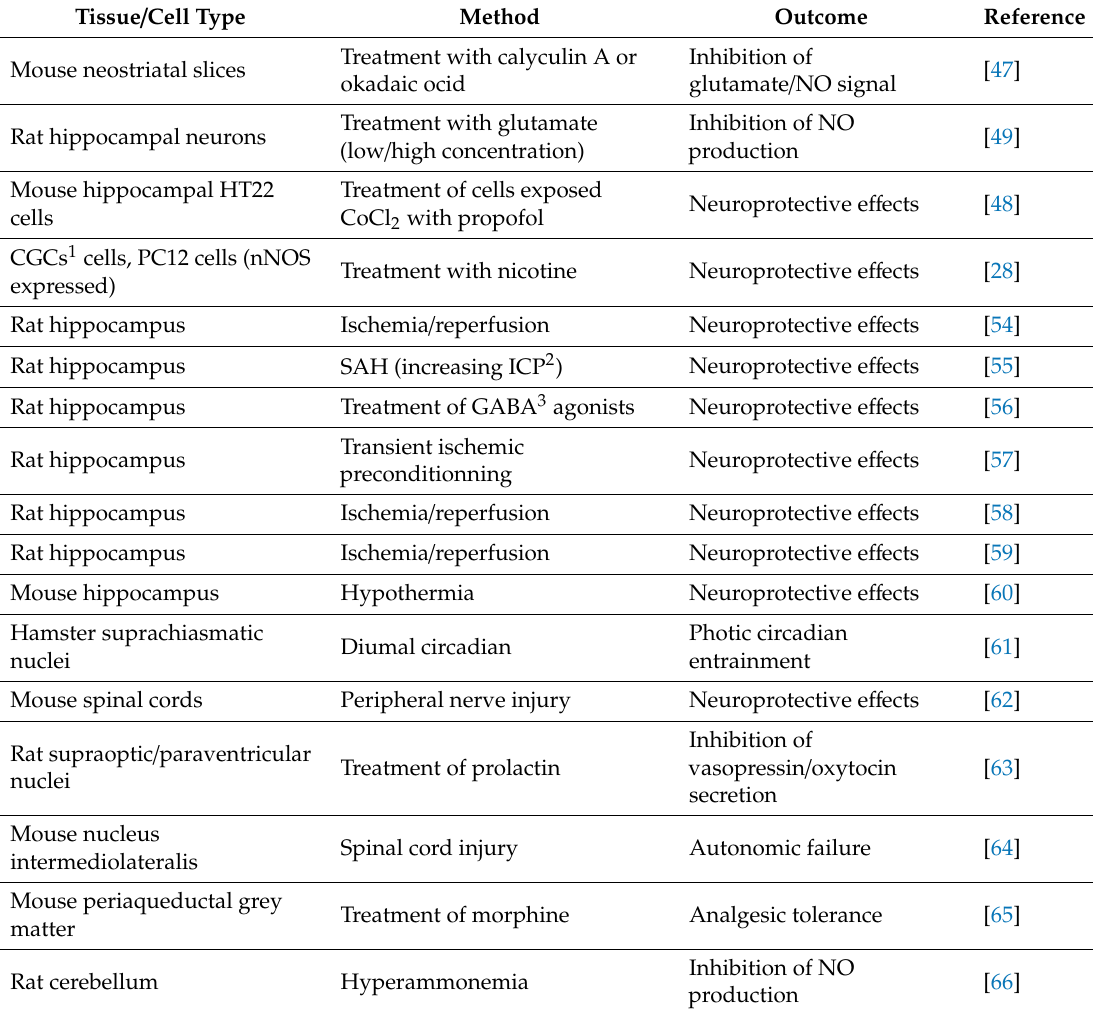
Table 1. Pathophysiological role of phospho-nNOS at Ser847 in neurons. Tissue / Cell